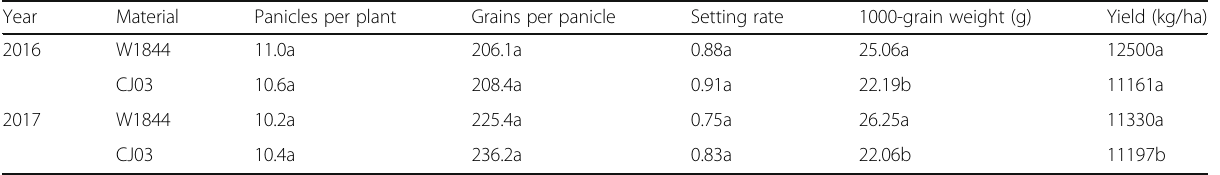
Table 1 Yield and yield components of the test materials